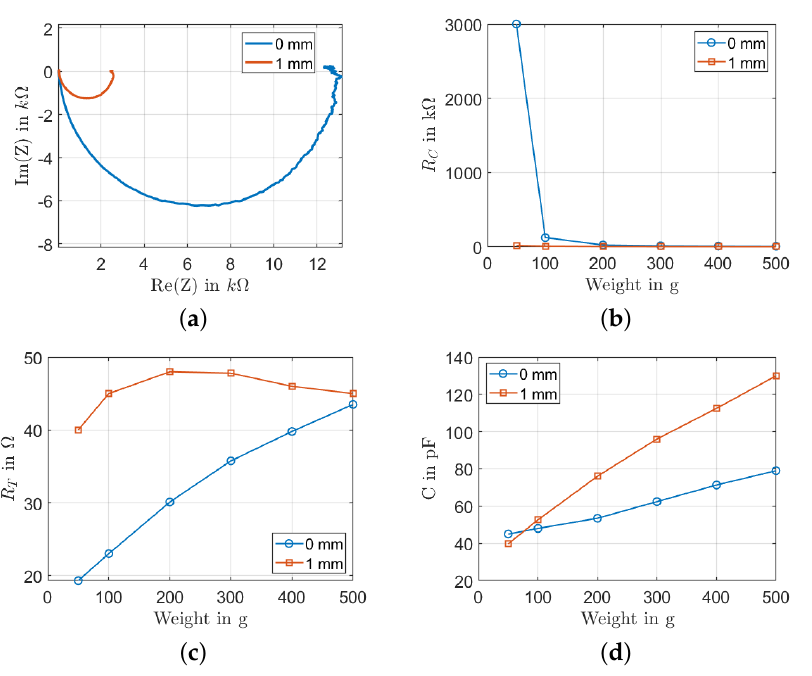
Figure 10. Influence of the snap-off distance: ( a ) Nyquist plot at a load of 300 g; ( b ) R C change with different loads; ( c ) R T change with different loads; ( d ) C change with different